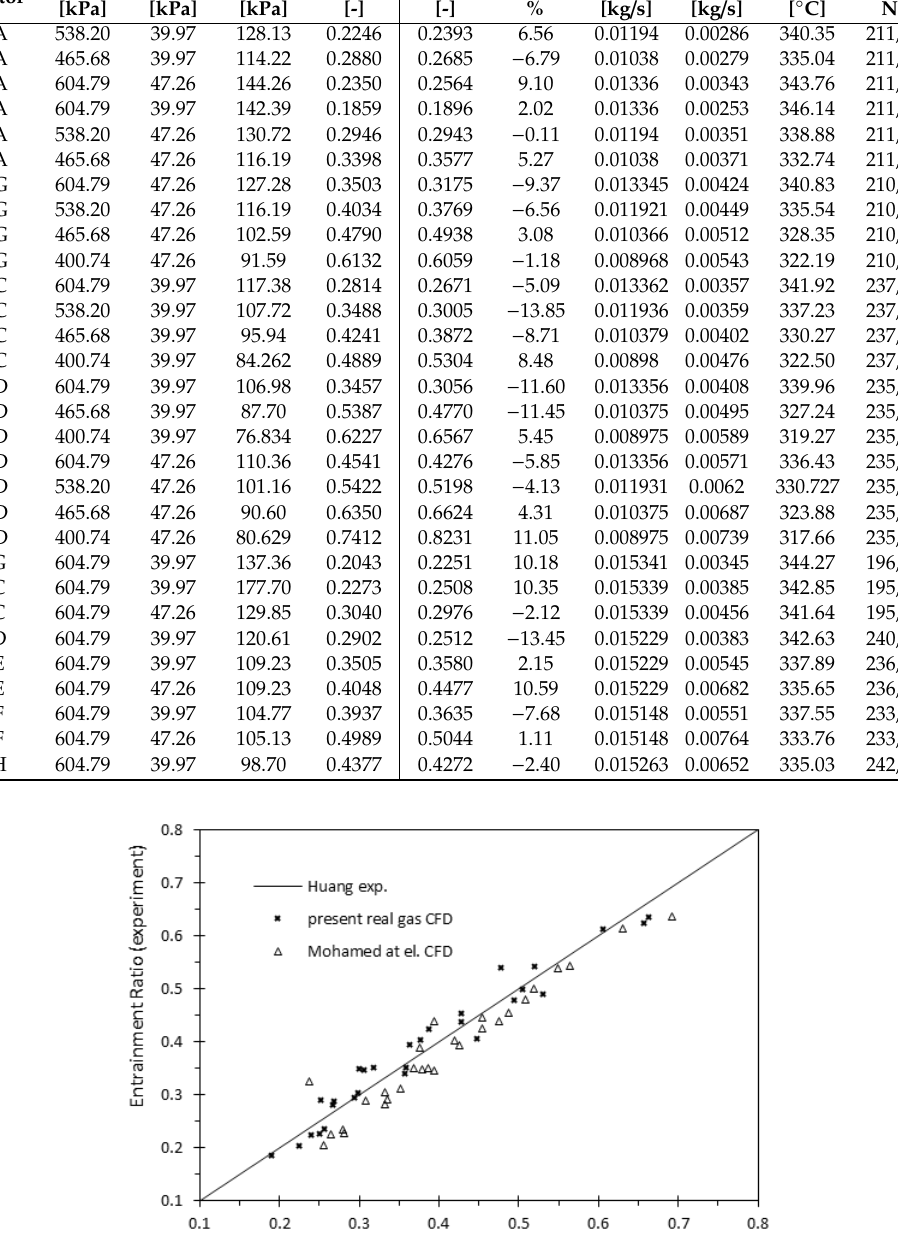
Table 2. Verification of the CFD results with Huang et al. experimental results.